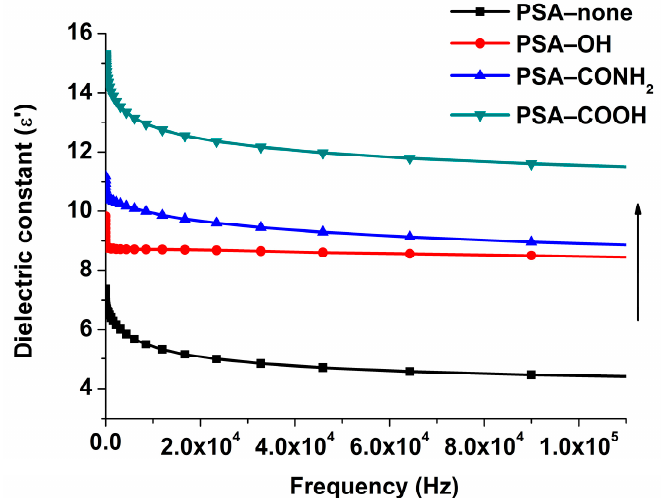
Figure 9. Normalized dielectric constant ε′ as a function of frequency of the PSA − none, PSA − OH, PSA − COOH, and PSA − CONH 2 .